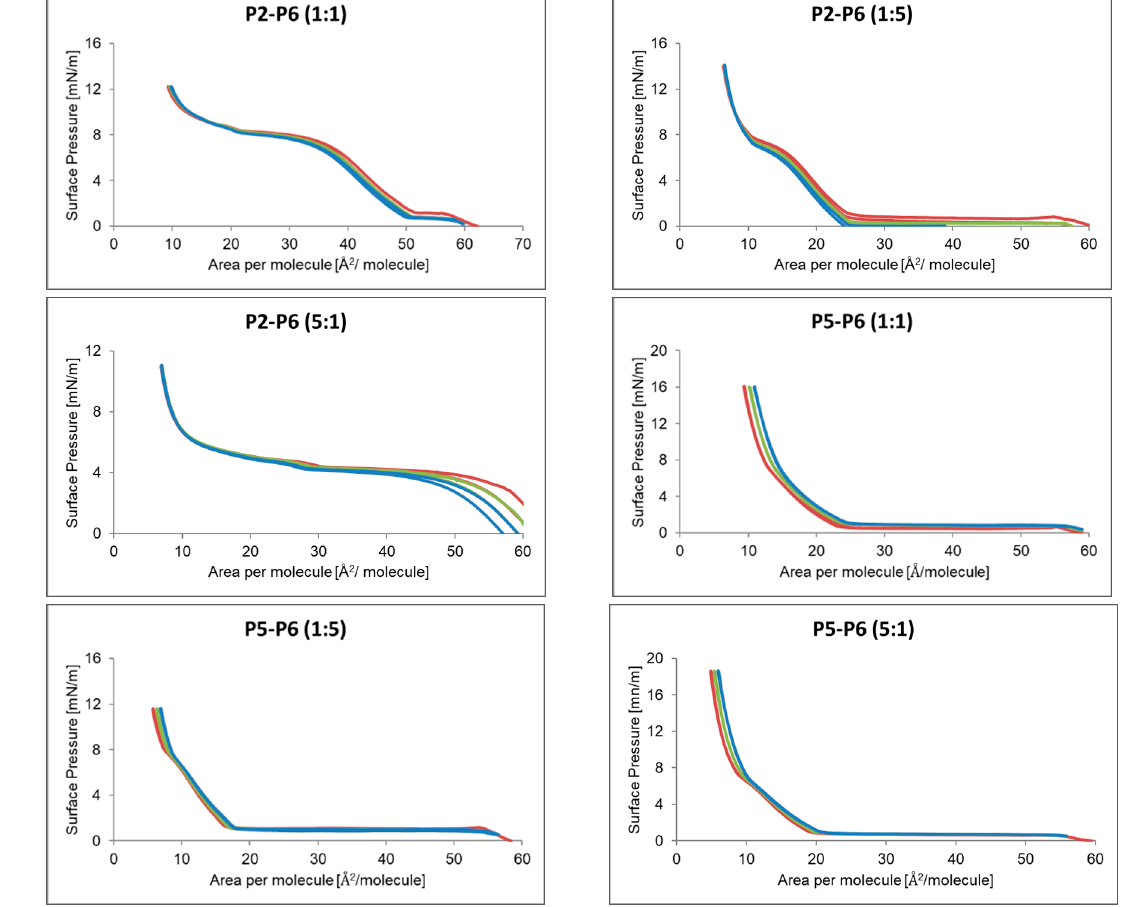
Figure 7. Hysteresis of the mixtures P2, P5, P6 peptide in different proportion. Loop 1 ( - ), Loop 2 ( - ), Loop 3 ( - ).